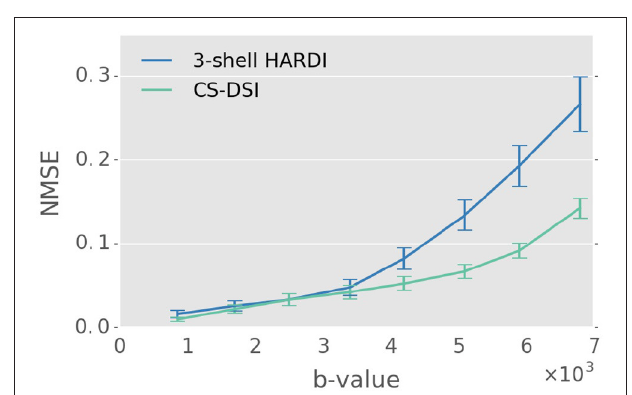
FIGURE 3 | For 3-shell HARDI, CS-DSI, and CHARMED data of Group B the respective signals for the diffusion directions of the CHARMED reference protocol were reconstructed using the MAPL MRI model. The NMSE with respect to the CHARMED reference signal was computed as a function of the b -value for both 3-shell HARDI and CS-DSI. Superior reconstruction quality is observed for CS-DSI in the b -value regime above 4,000 s/mm 2